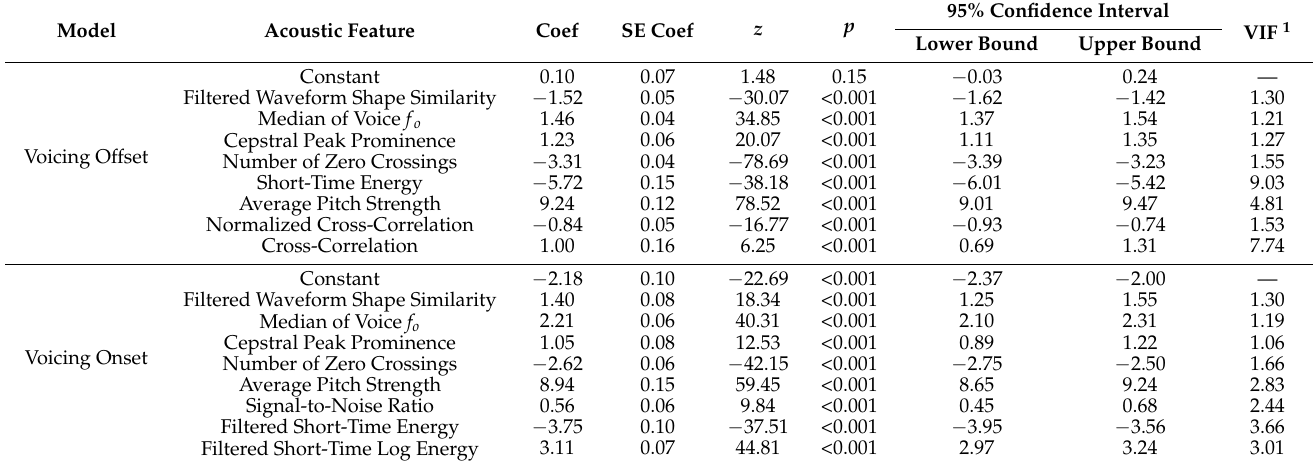
Table 4. Summary of significant variables in the stepwise binary logistic regression statistical model.